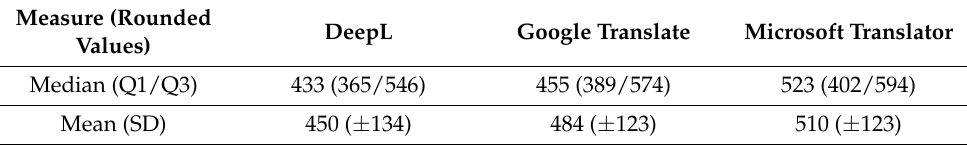
Table 1. Average word count per plain language summary (PLS) per machine translation engine (MTE) as arithmetic means with standard deviations and medians with interquartile